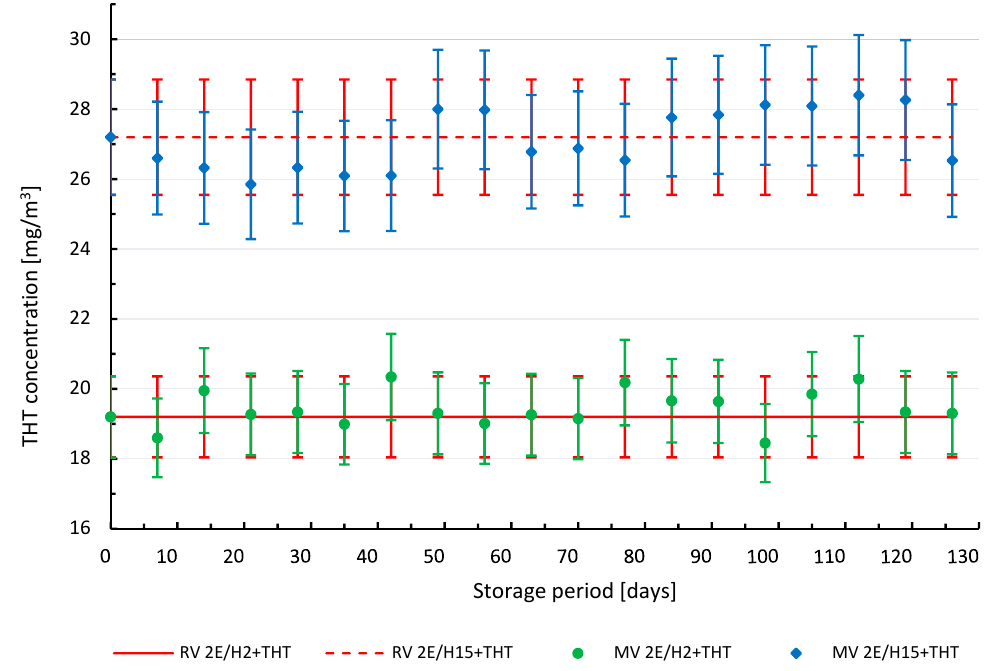
Figure 6. Results of testing the stability of THT concentration in gaseous mixtures of 2E/H + THT (T = 20 °C and P = 101.325 kPa).